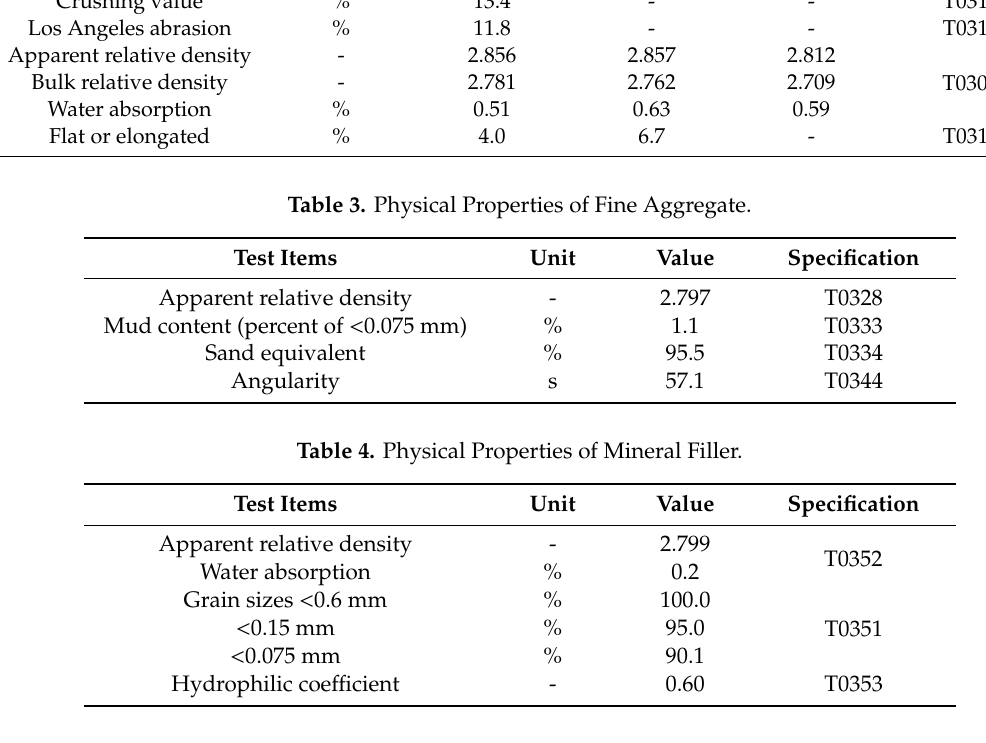
Table 5. The Gradation of Aggregates.